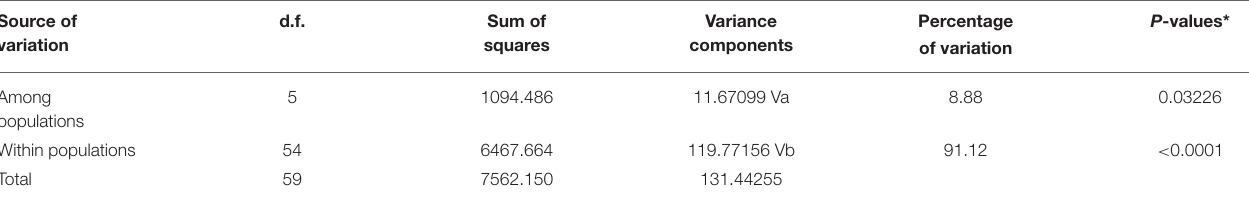
d.f. Sum of Variance squares